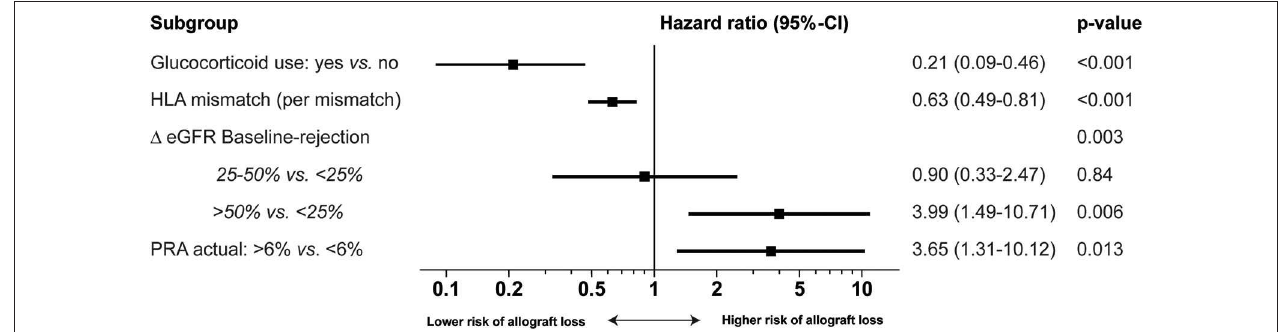
FIGURE 3 | Multivariable Cox proportional hazard regression analysis of risk for allograft loss in alemtuzumab-treated patients. Multivariable analysis of the risk of allograft loss with hazard ratio [Exp(B), 95%-confidence interval and p -value]. Delta ( 1 ) eGFR baseline-moment of rejection is the percentage change between the baseline eGFR and eGFR at the moment of rejection. Glucocorticoid use means maintenance therapy with glucocorticoids during the rejection. PRA Panel reactive antibodies.